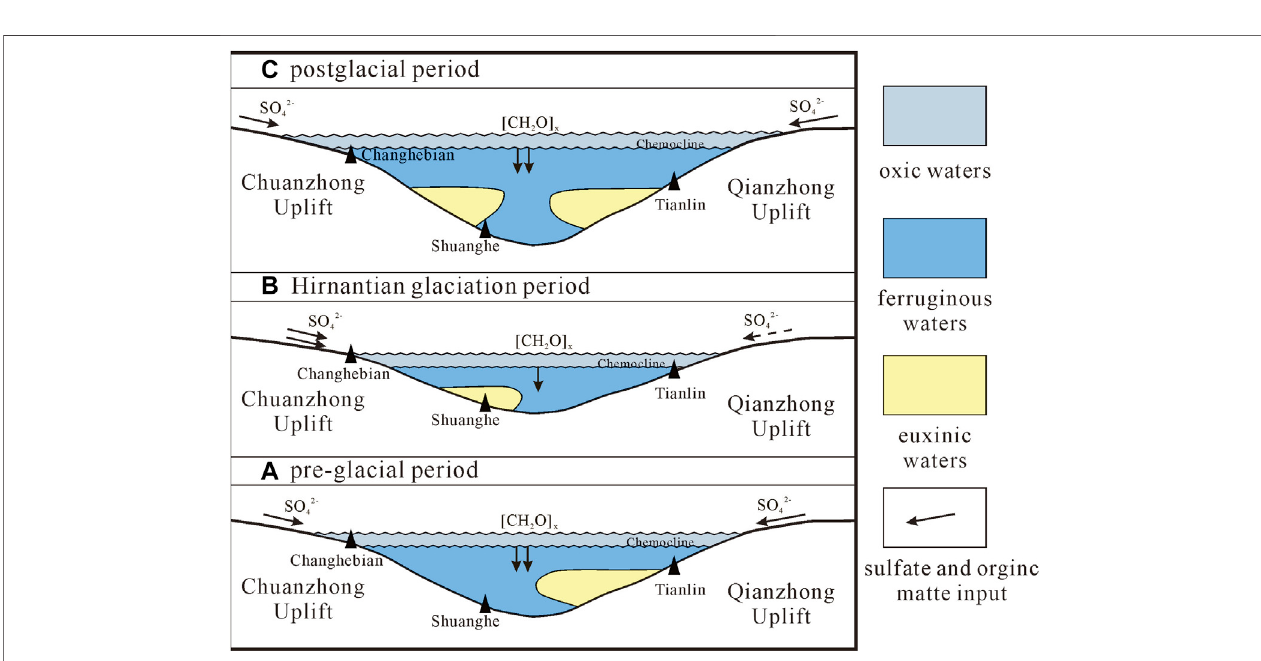
FIGURE 11 | Depositional model of A-A ’ ( Figure 1C ) during the Late Ordovician to Early Silurian. (A) Pre-glacial period; (B) Hirnantian glaciation period; and (C) postglacial period in the southwest depocenter of the Upper Yangtze Basin.